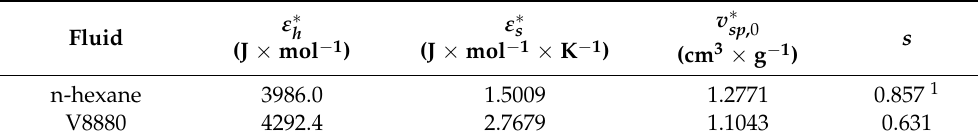
Table 1. NRLF parameters calculated by best fitting